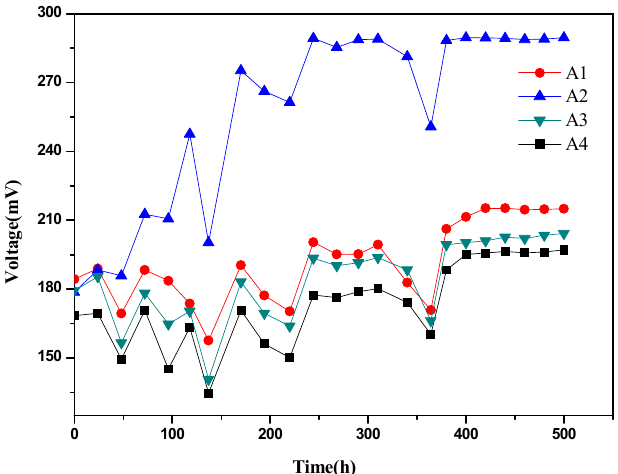
Figure 2. Cell voltage as a function of time with an external resistance of 1000 Ω during start-up (A1: 0.1 g zero-valent iron; A2: 0.5 g zero-valent iron; A3: 1 g zero-valent iron; A4: no zero-valent iron).